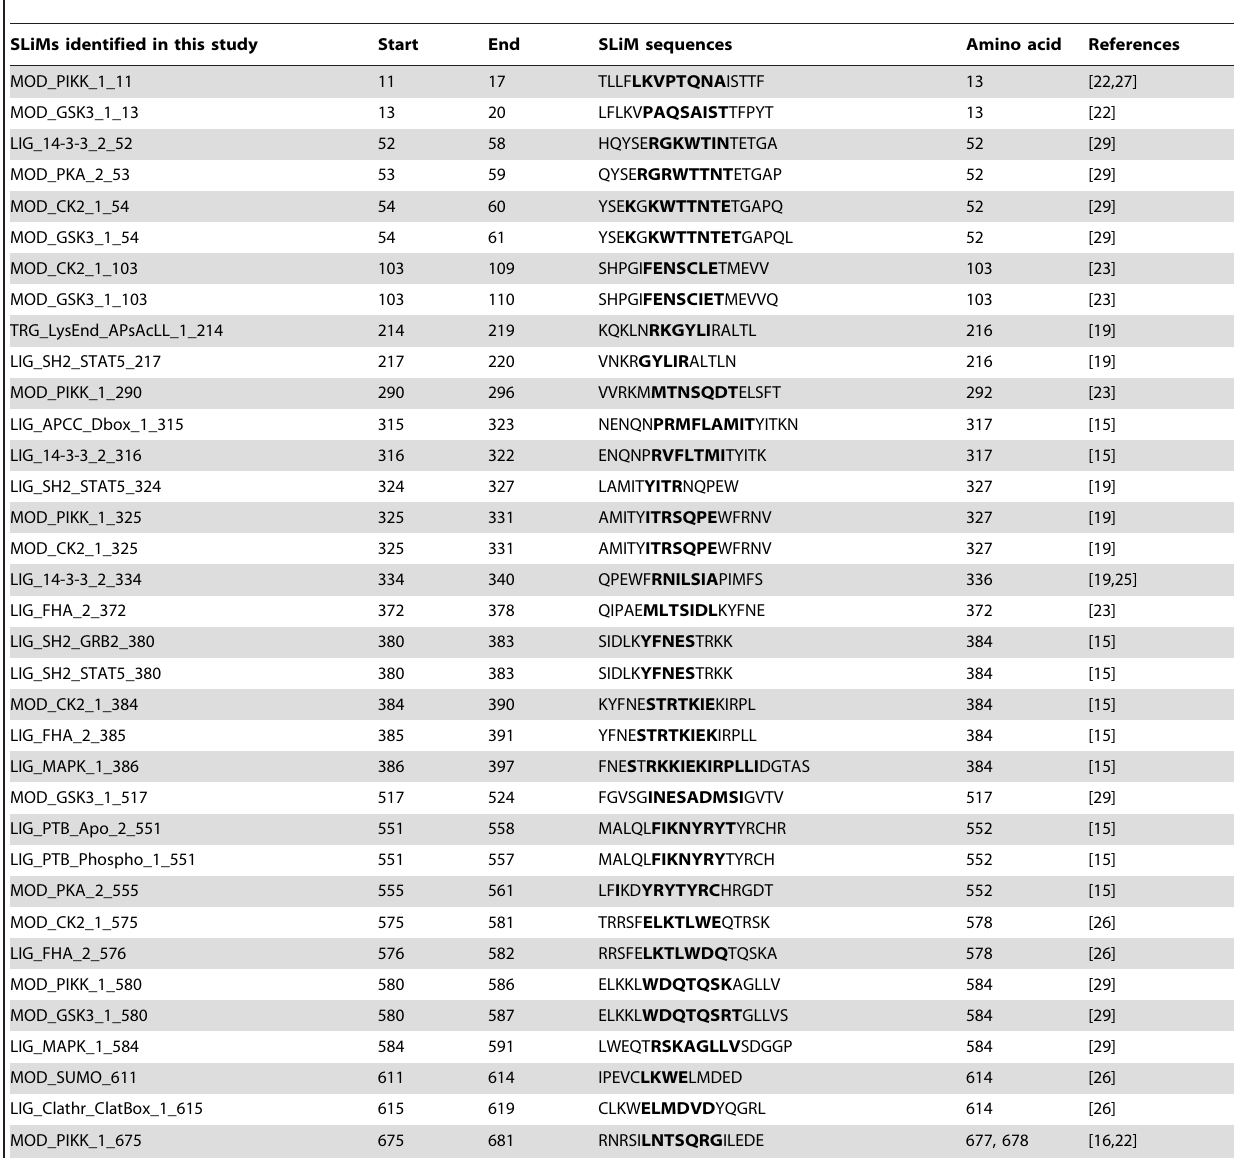
Table 3. SLiMs mapped to the vicinity of amino acids that were reported as genetic signatures or are associated with the adaptation of IAV PB1 proteins to the